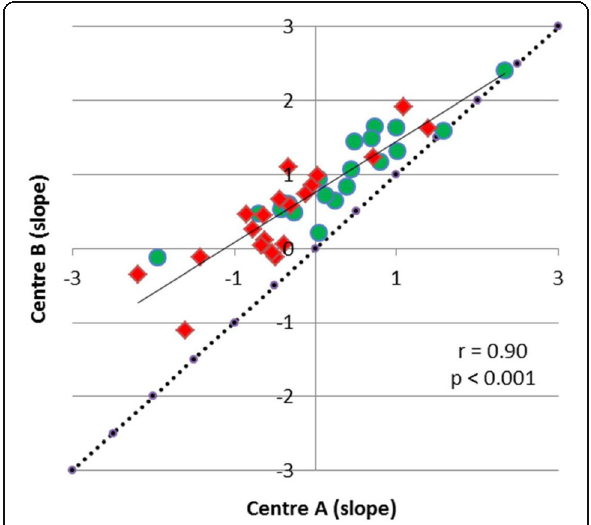
Fig. 6 Correlation of slope of the TAC of 18 F-FET uptake from 10 to 40 min p.i. There is a significant correlation but a deviation from line of unity indicating lower slope values for centre A. High-grade tumours are indicated by red symbols and low-grade tumour by green